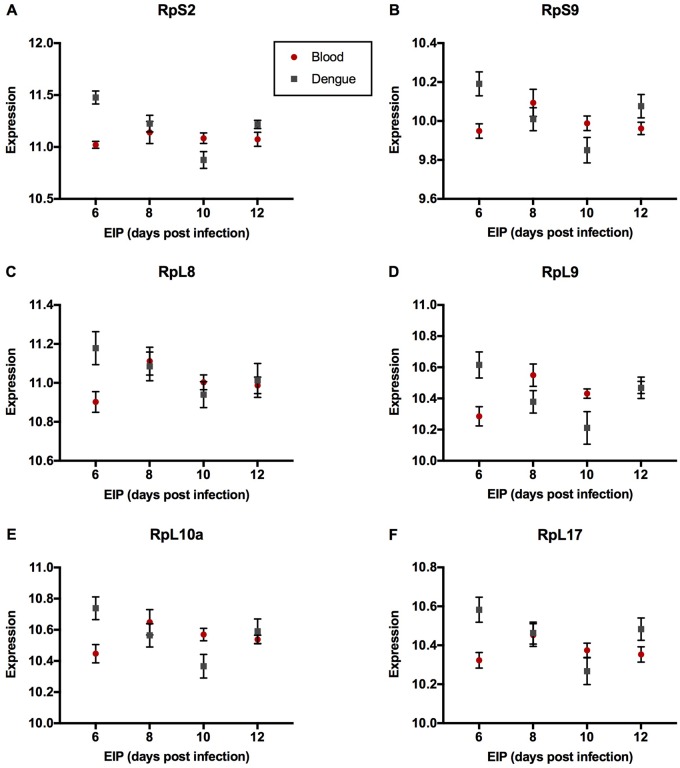
—Genes of enriched GO term GO:0006412 translation. Expression levels by EIP phenotype of (A) RpS2, (B) RpS9, (C) RpL8, (D) RpL8, (E) RpL10a, and (F) RpL17 are shown. Expression levels were estimated from read counts from RNAseq data. Red circles depict mosquitoes fed with a naïve blood meal, while gray squares depict those fed with a viremic blood meal. Mean and SEM are shown in graphs (n = 6 per group per treatment).